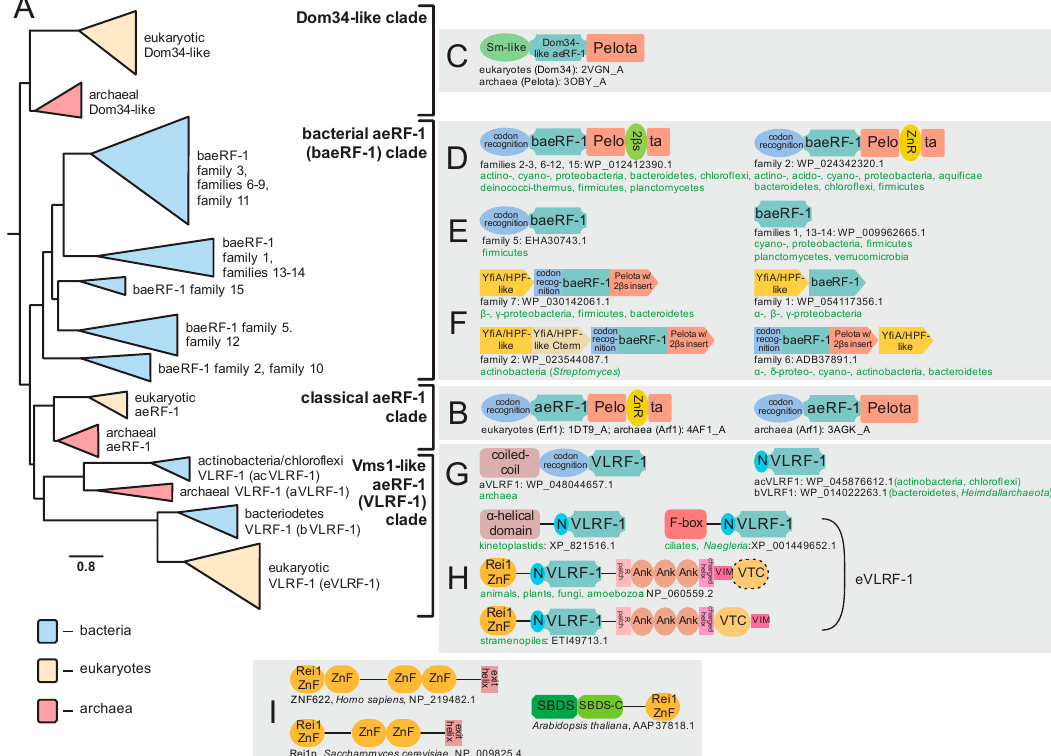
Figure 3. Evolution of aeRF-1 superfamily with known domain architectures and conserved gene neighborhoods. ( A ) Collapsed phylogenetic tree depicting relationships within the aeRF-1. ( B–I ) Notable domain architectures and conserved gene neighborhoods grouped according to clades. Individual domains of any given single protein architecture are depicted as discrete, colored shapes. In ( F ), individual genes in conserved gene neighborhoods are depicted as boxed arrows with the arrowhead pointing in the 3 ′ direction. Genes with multiple domains have their boxes split into distinct colors, one color for each discrete domain. Domain abbreviations: VTC, Vms1 Treble Clef; ZnR, zinc ribbon; 2 β s, 2- β -strand insert domain; SBDS, Shwachman-Bodian-Diamond syndrome; N, distinctive N-terminal extension shared between certain families of the VLRF-1 clade.